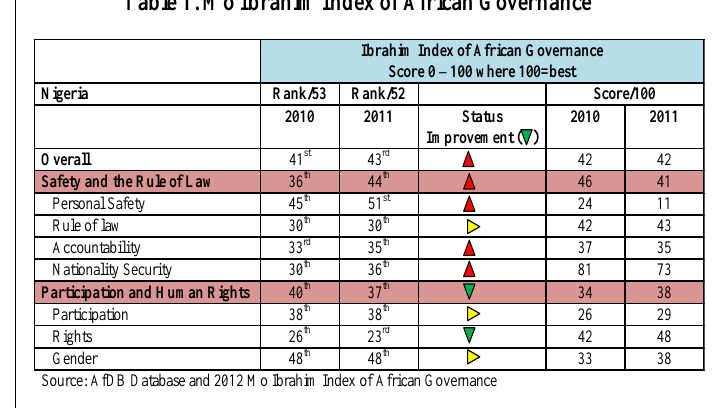
Table 1. Mo Ibrahim Index of African